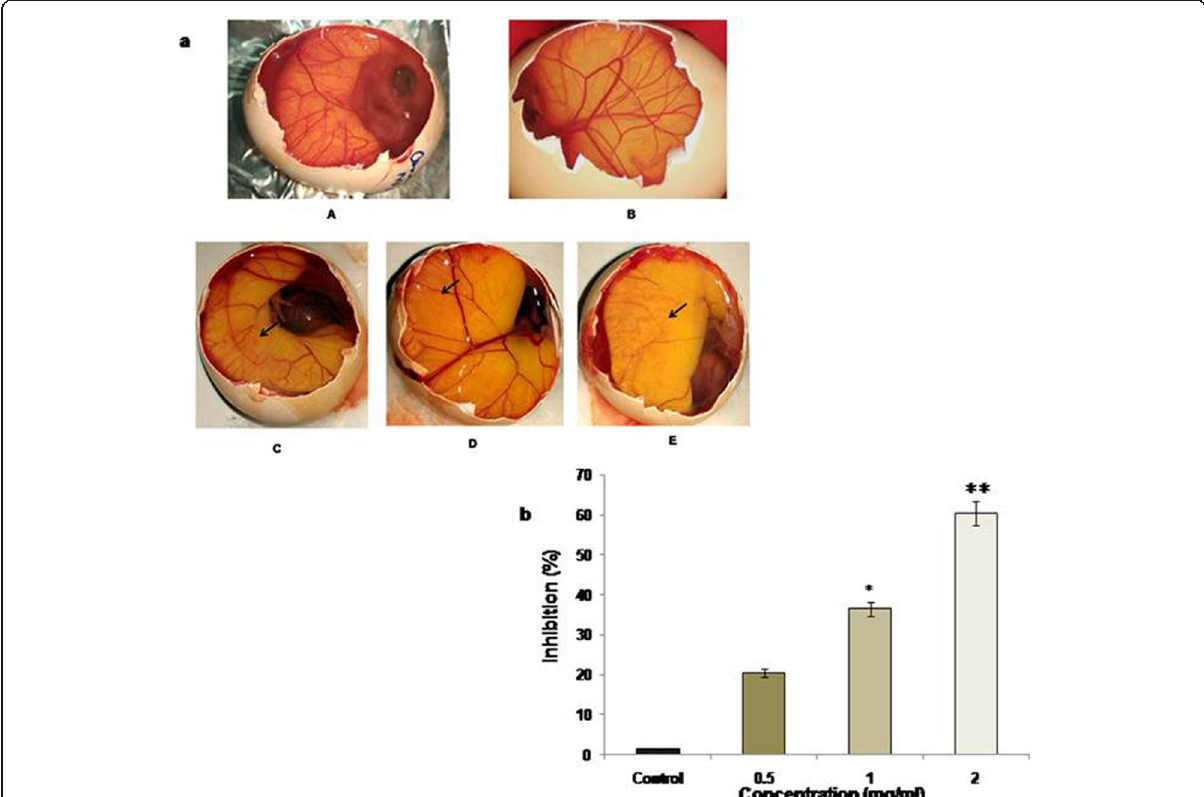
Fig. 10 Anti-angiogenesis effect of C. minima on chick embryos. a (A) Control chick embryo, (B) DMSO treated control, (C) 0.5 mg/mL treated, (D) 1.0 mg/mL treated, (E) 2.0 mg/mL treated. Arrow indicates the inhibition of blood vessel branch points b Percentage Inhibition of blood vessels in 8-day-old chick embryos treated with C. minima. The values are expressed as mean ± SE. An asterisk denotes significance at p < 0.05 and two asterisks denotes significance at p <